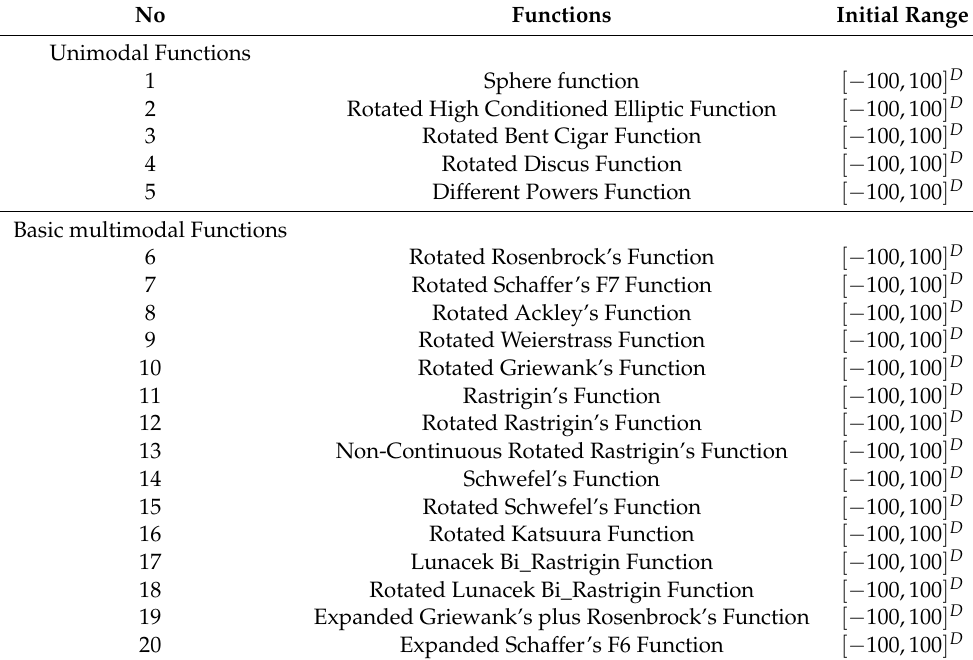
Table 1. CEC2013 benchmark suite